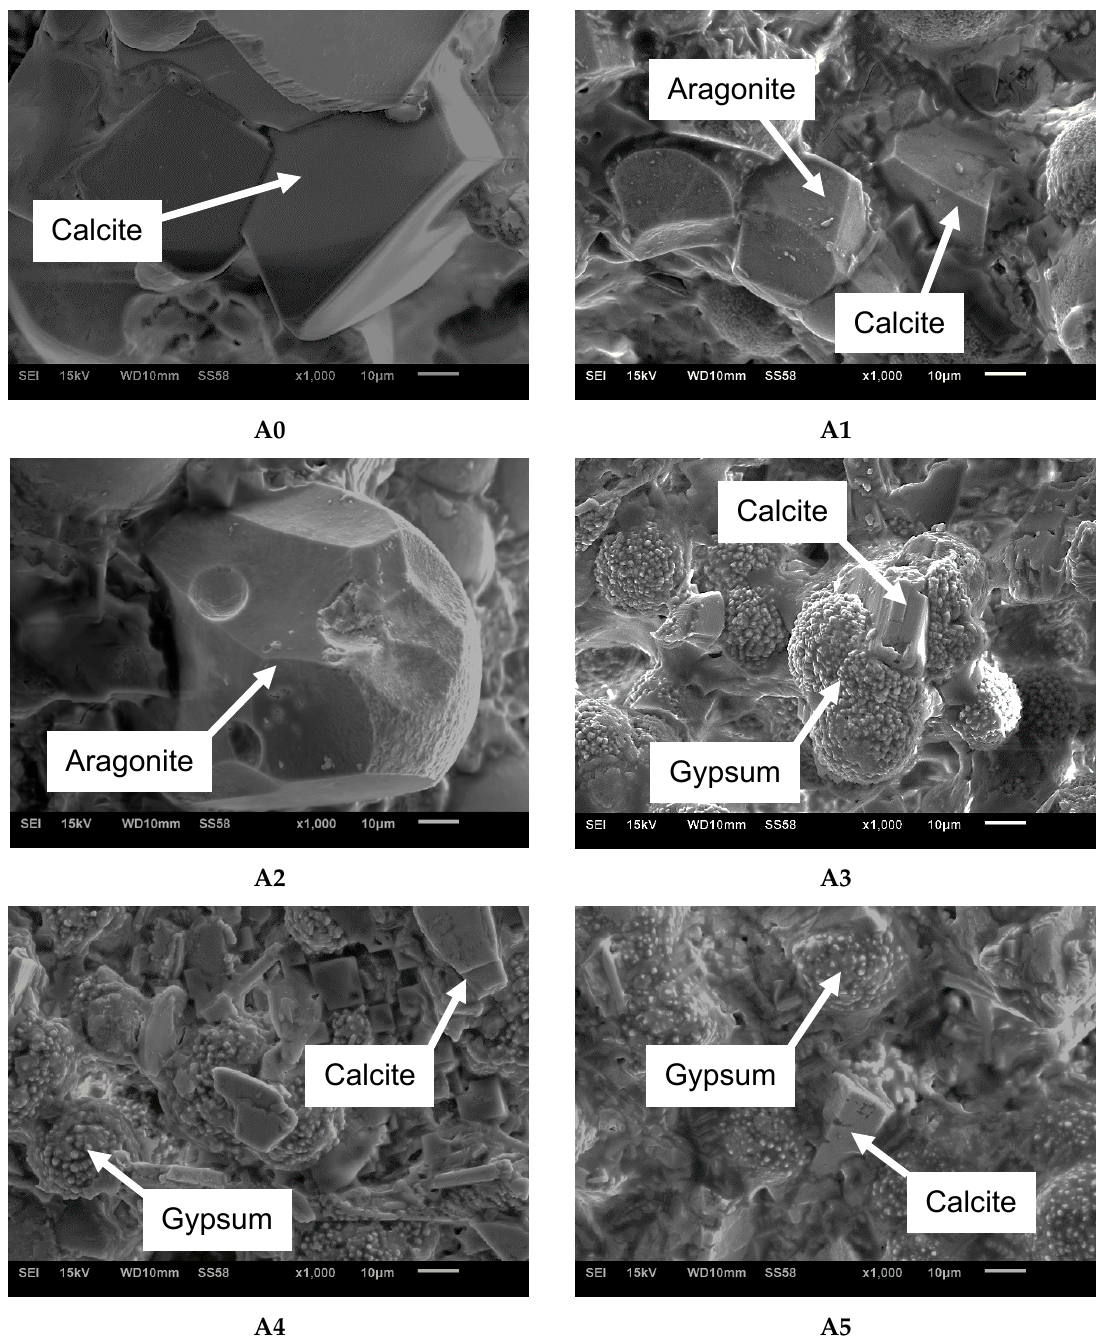
Figure 9. Scanning electron microscopy of precipitated minerals.